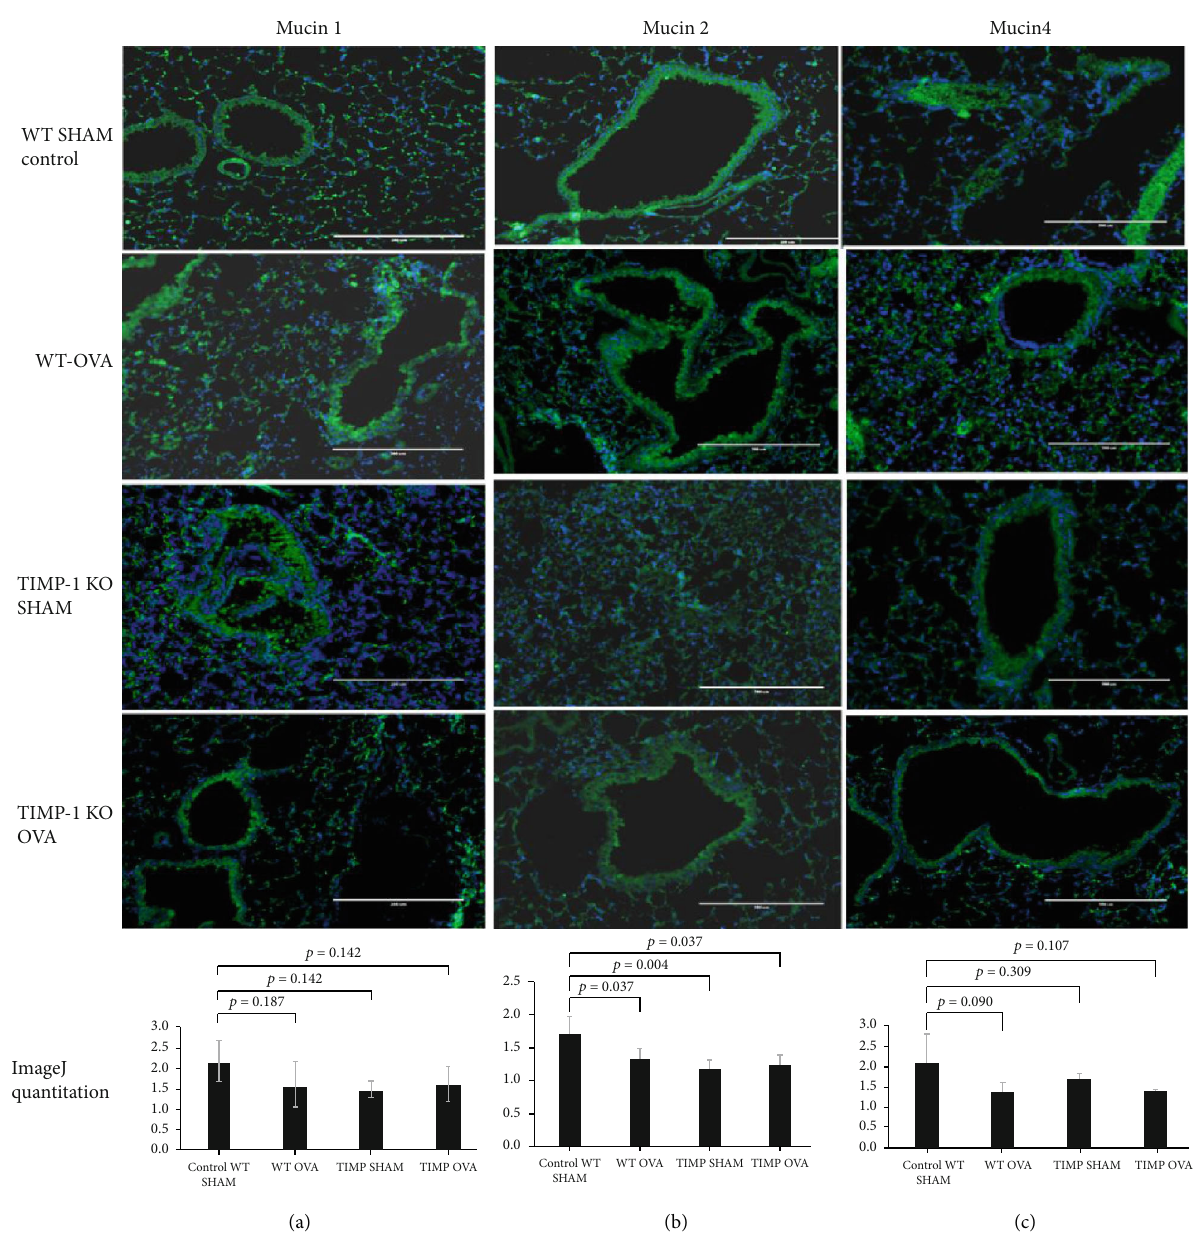
Figure 3: Membrane-bound mucins MUC1, MUC 2, and MUC4 expression in lung tissue obtained from OVA-sensitized TIMPKO, OVA- sensitized TIMPKO, OVA-sensitized WT, and WT-SHAM mice. Representative images of immuno fl uorescent staining of MUC1 (a), MUC2 (b), and MUC4 (c). The fl uorescent intensity was quantitively assessed via the ImageJ software, with the representative histogram describing the data obtained from n = 3 separate experiments with WT-SHAM